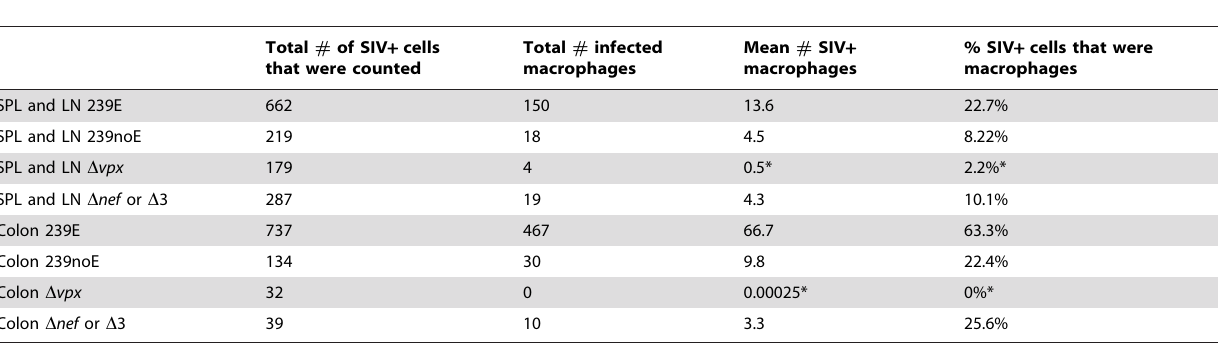
Table 4. Summaryoflentiviral infection of macrophages in spleen, lymph node, anin macaques inoculated intravenously